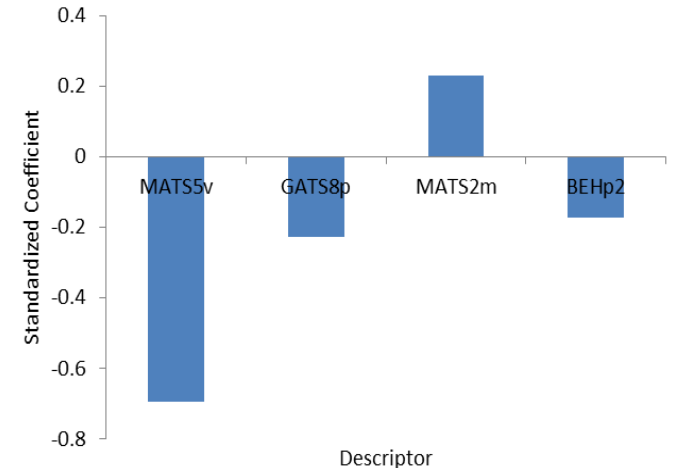
Figure 3. Standardized coefficients versus descriptors in MLR model.